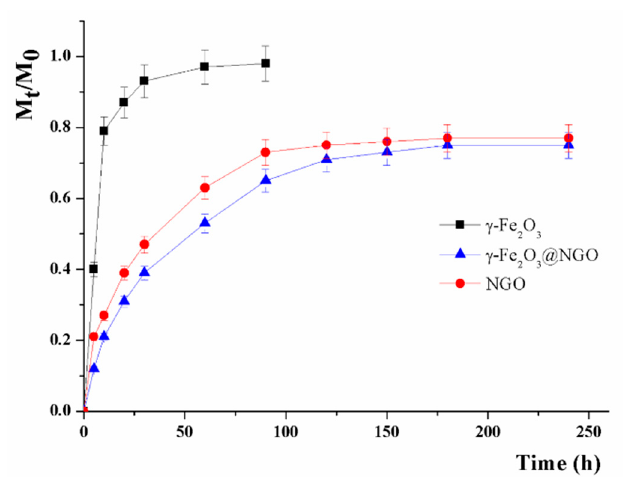
Figure 7. CisPt release profiles from γ -Fe 2 O 3 @NGO, γ -Fe 2 O 3 , and NGO.